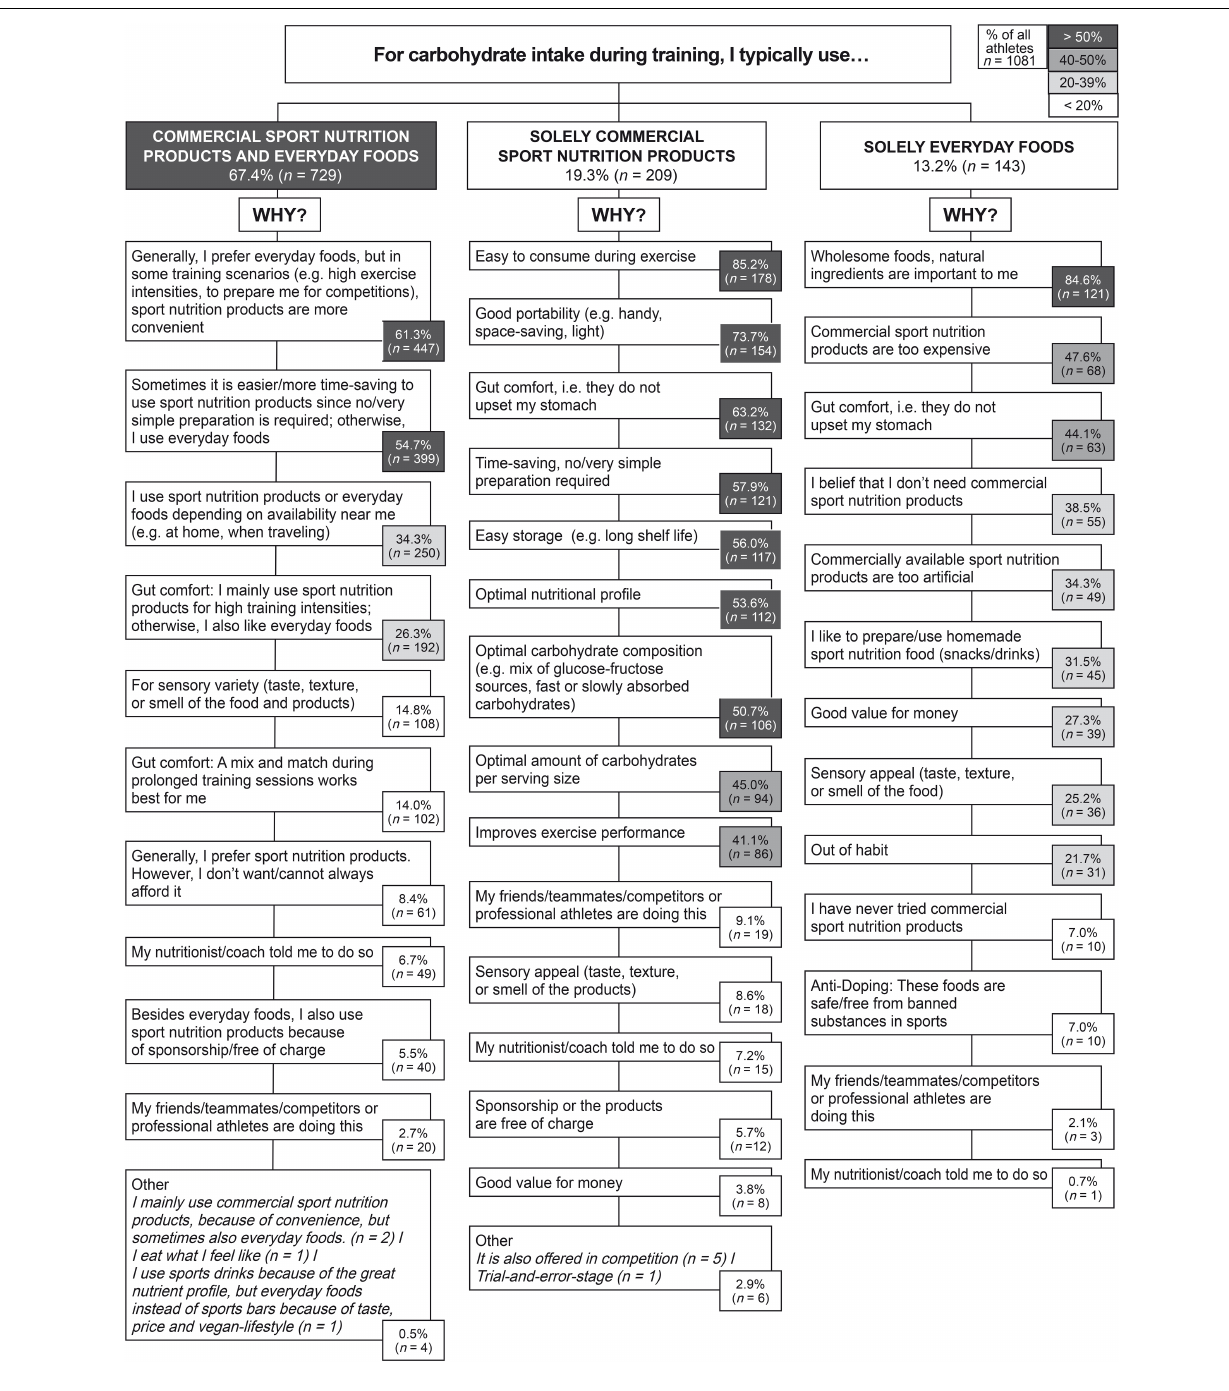
FIGURE 2 | Reasons for using a combination of commercial sport nutrition products and everyday foods, solely commercial sport nutrition products, and solely everyday foods for carbohydrate intake during training sessions. Percentages reflect the % of participants who chose a specific answer in relation to all participants who were presented with a given